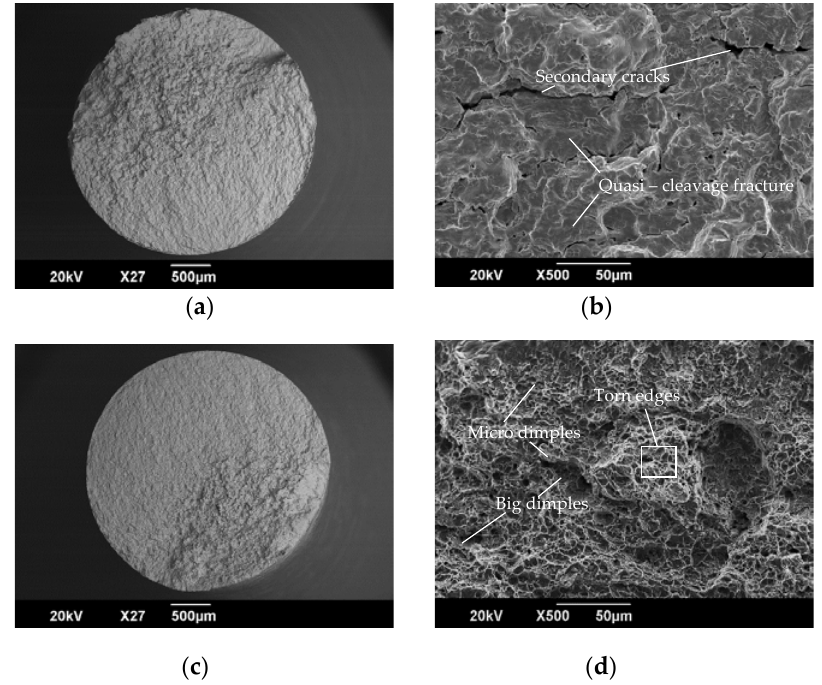
Figure 3. SEM images of EN8 fractured surface for untreated ( a , b ) and treated ( c , d ).